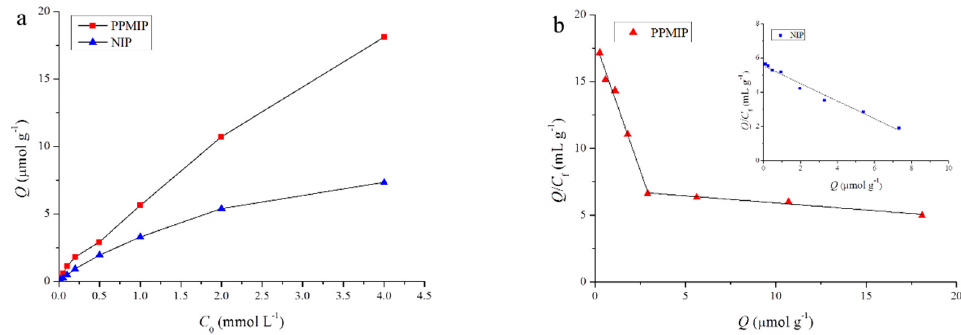
Figure 2. ( a ) BPA binding isotherms for PPMIP and NIP; ( b ) Scatchard plot for PPMIP (inset: Scatchard plot for NIP).